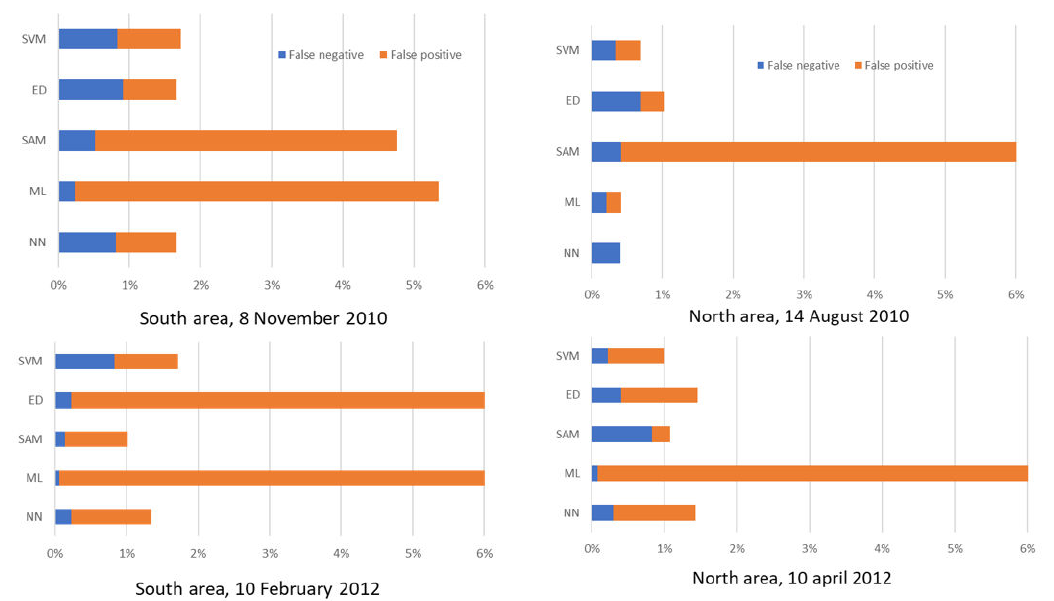
Figure 9. ( Left ) Relative false negative (blue) and positive (orange) errors (in %) in the retrieved pixel classification for the southern area for the dates before and after the tsunami. ( Right ) Relative false negative (blue) and positive (orange) errors (in %) in the retrieved pixels classification for the northern area for the dates before and after the